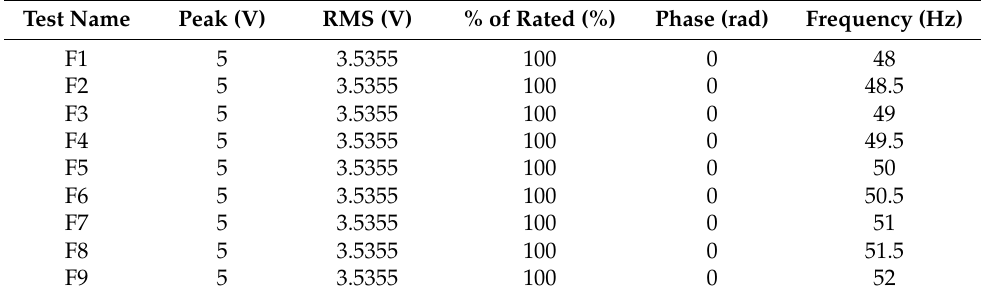
Table 12. Settings of the frequency tests.